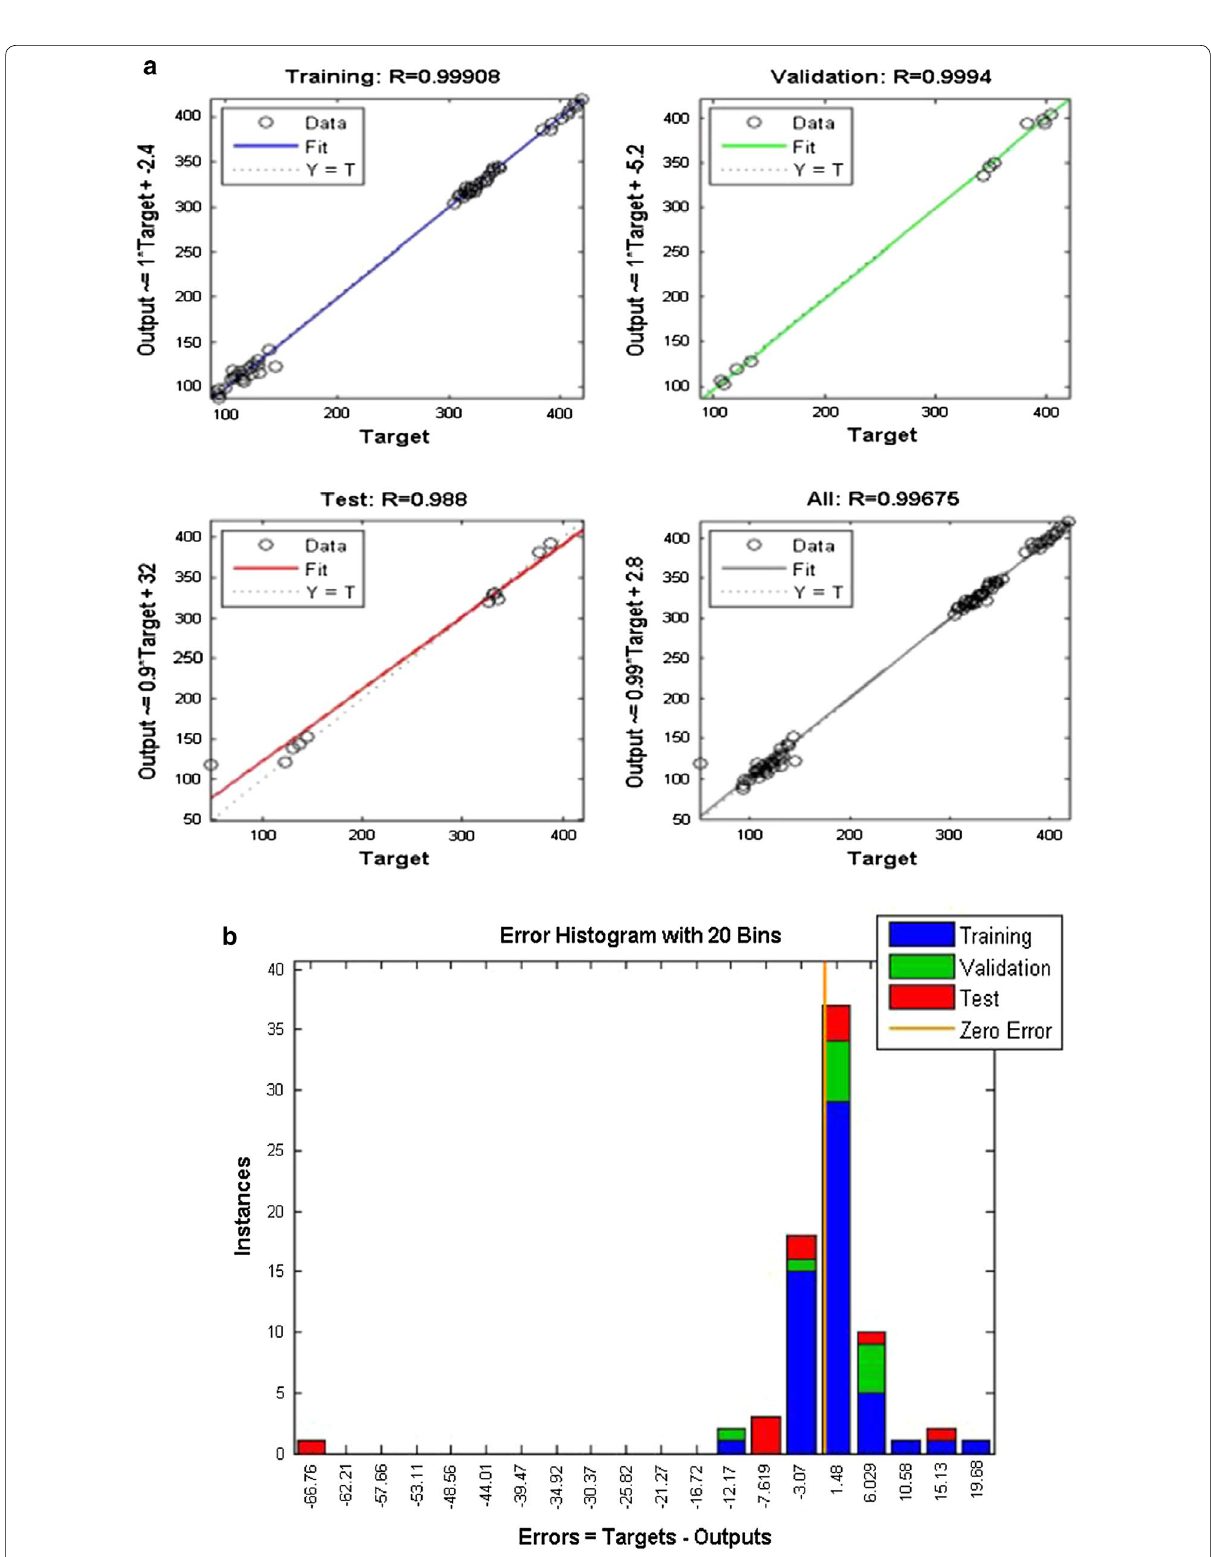
Fig. 1 a The graphical depiction of the regression results of training, validation and testing. b Error histogram plot of training of